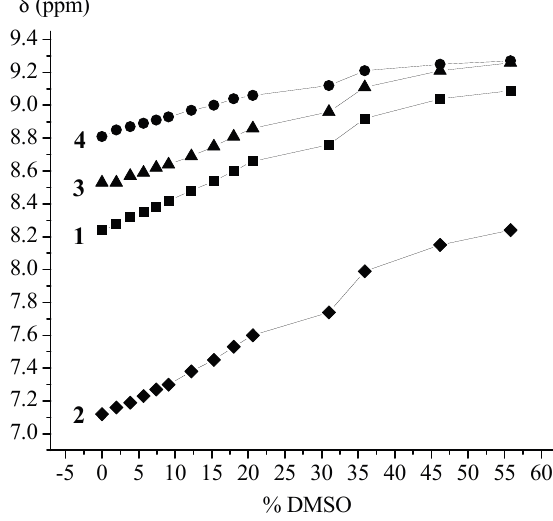
chemical shifts at varying concentrations trans